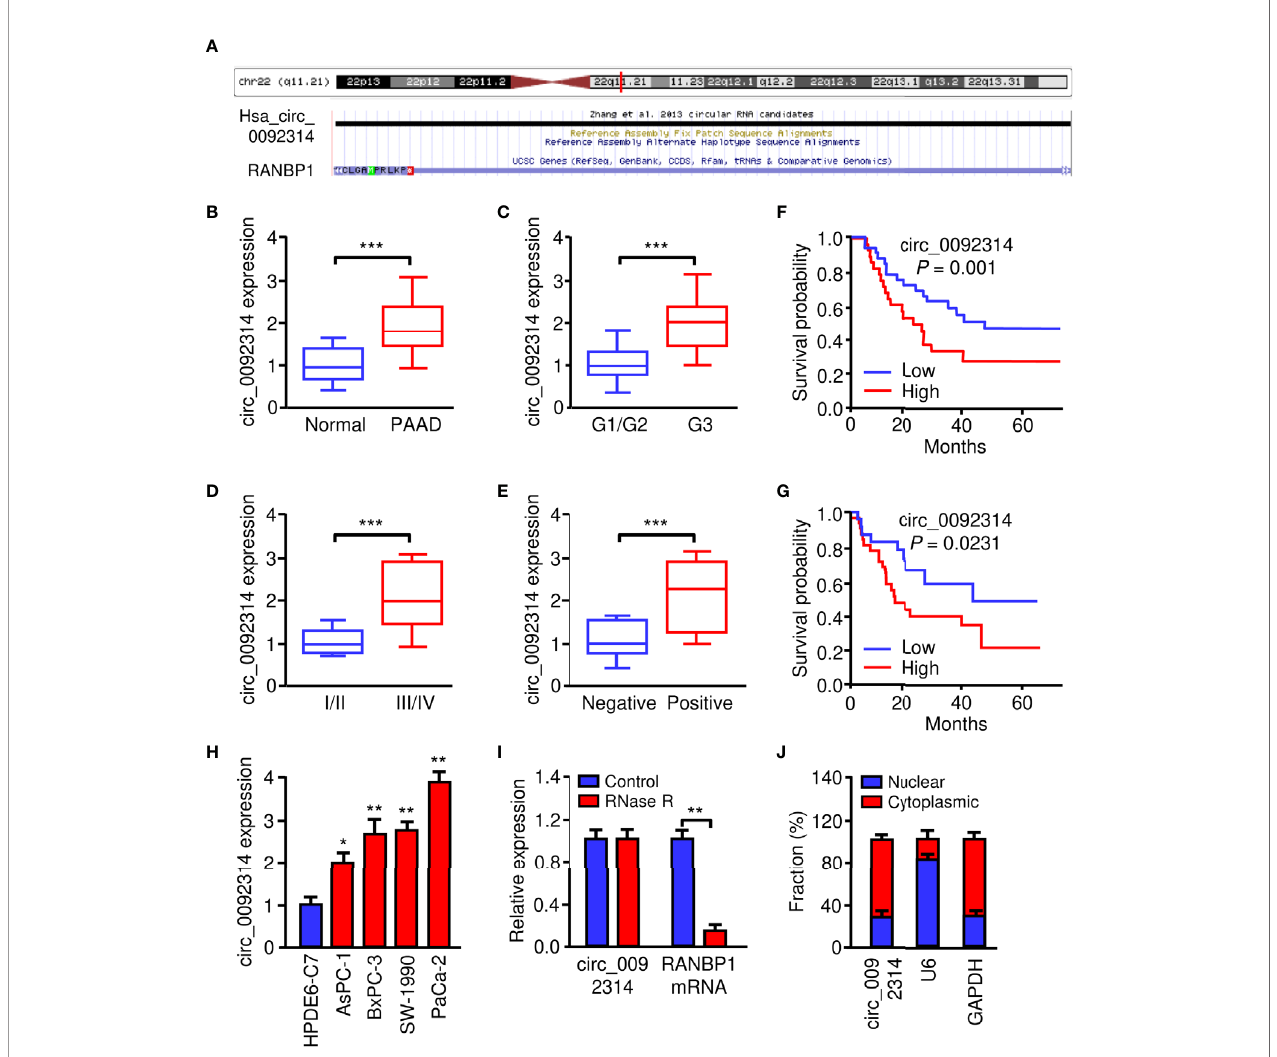
FIGURE 1 | Circ_0092314 is highly expressed in PAAD tissues and cells. (A) Human RANBP1 gene was identi fi ed as the host gene of circ_0092314 by browsing circBase database. (B) The expression of circ_0092314 in PAAD tissues (n=40) and their adjacent normal pancreatic tissues (n=40) was determined using qRT- PCR assay. (C) The expression of circ_0092314 in well/moderate and poor differentiated PAAD tissues from patients. (D) The expression of circ_0092314 in PAAD tissues from patients with stages I and II, or stage III and IV disease. (E) The expression of circ_0092314 in PAAD tissues from patients with (or without) lymph node metastasis. (F, G) Kaplan-Meier survival analysis showed that PAAD patients with high circ_0092314 expression have a lower overall survival (F) and disease-free survival (G) than those with low circ_0092314 expression. (H) qRT-PCR analysis of circ_0092314 expression in PAAD cell lines and HPDE6-C7 cells. (I) The expression of circ_0092314 and RANBP1 mRNA in PaCa-2 cells was detected using qRT-PCR assay in the presence or absence of RNase R. (J) The nuclear- cytoplasmic fractionation assay showed that circ_0092314 was mainly located in the cytoplasm. * P <0.05, ** P <0.01, *** P